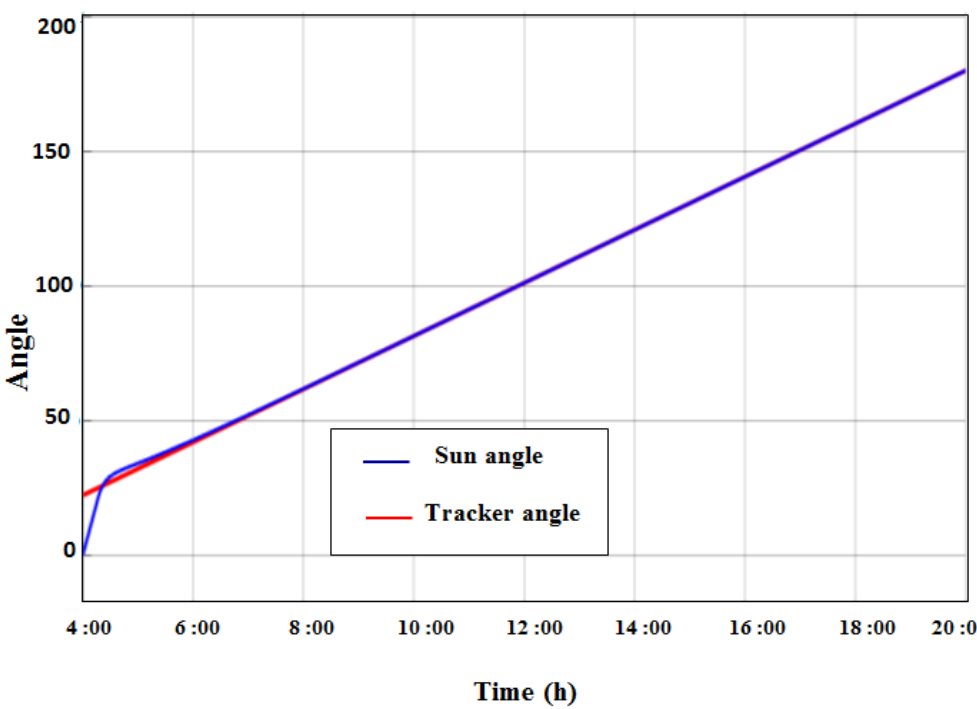
Figure 15. Comparison between sun angle and sun tracker angle. Figure 16a–d show the values variation of illuminance, voltage, current, and power of a PV module for two cases (with and without the tracker), which are compared for the period spanning from sunrise to sunset. When the curves are examined between 8:00 a.m.